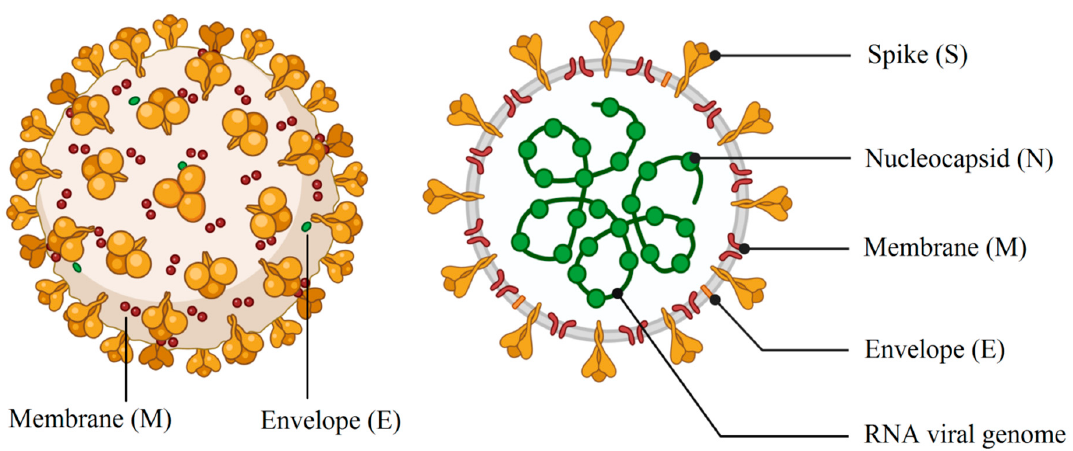
Figure 1. Schematic drawing of main components of spherical or pleiomorphic coronaviruses (credit: biorender.com).